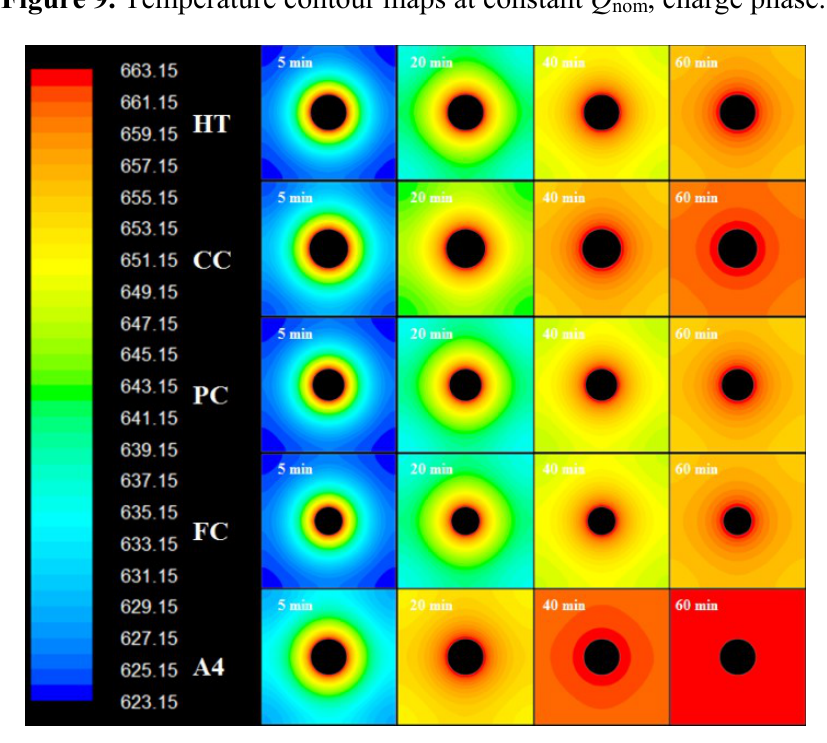
Figure 9. Temperature contour maps at constant Q